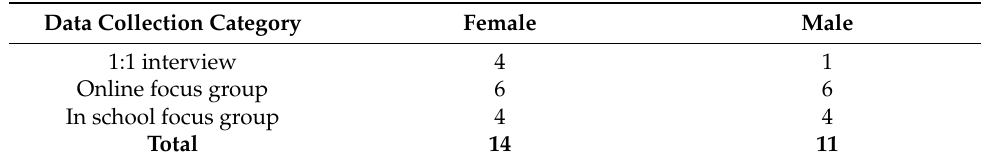
Table 1. Participant and data collection